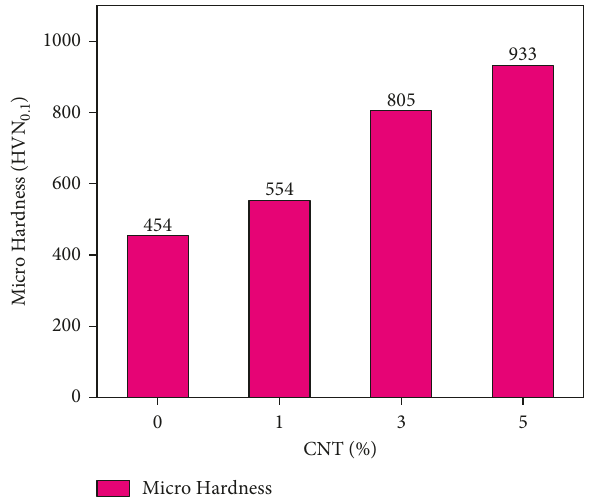
Figure 6: Microhardness of coating system at different percentage proportions of CNTs reinforcement.